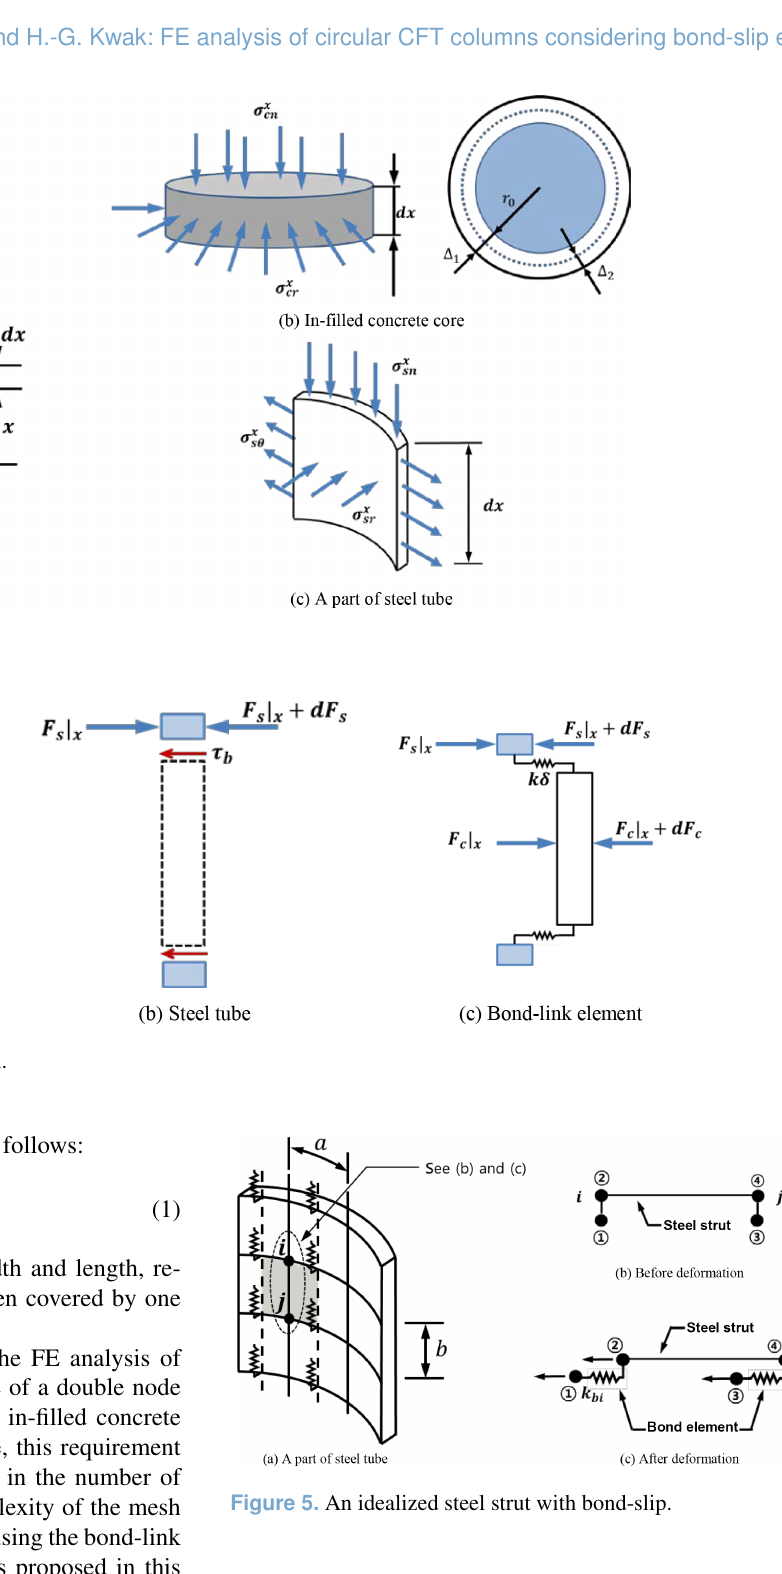
the steel strut with the bond-link elements attached at its end points is then selected. Figure 5b and c show this element before and after deformation, where points 1 and 3 are as- sociated with the in-filled concrete and points 2 and 4 are associated with the steel tube at nodes i and j ,